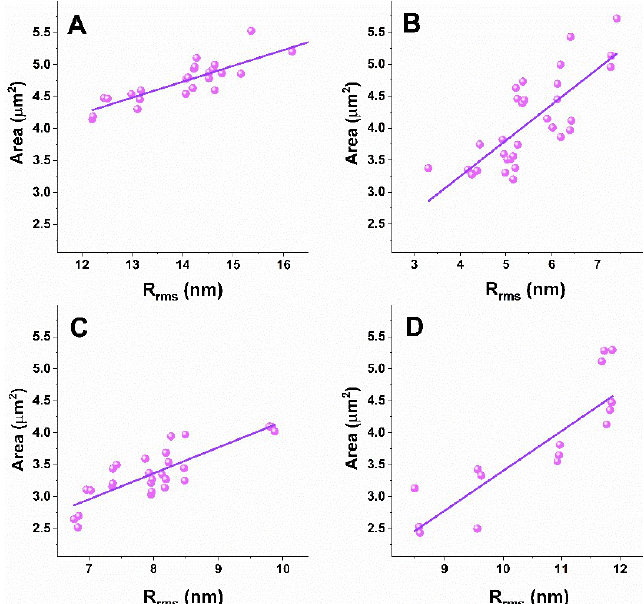
Figure 6. Scatter plots of Area against R rms for the platelets derived from the healthy individuals ( A )